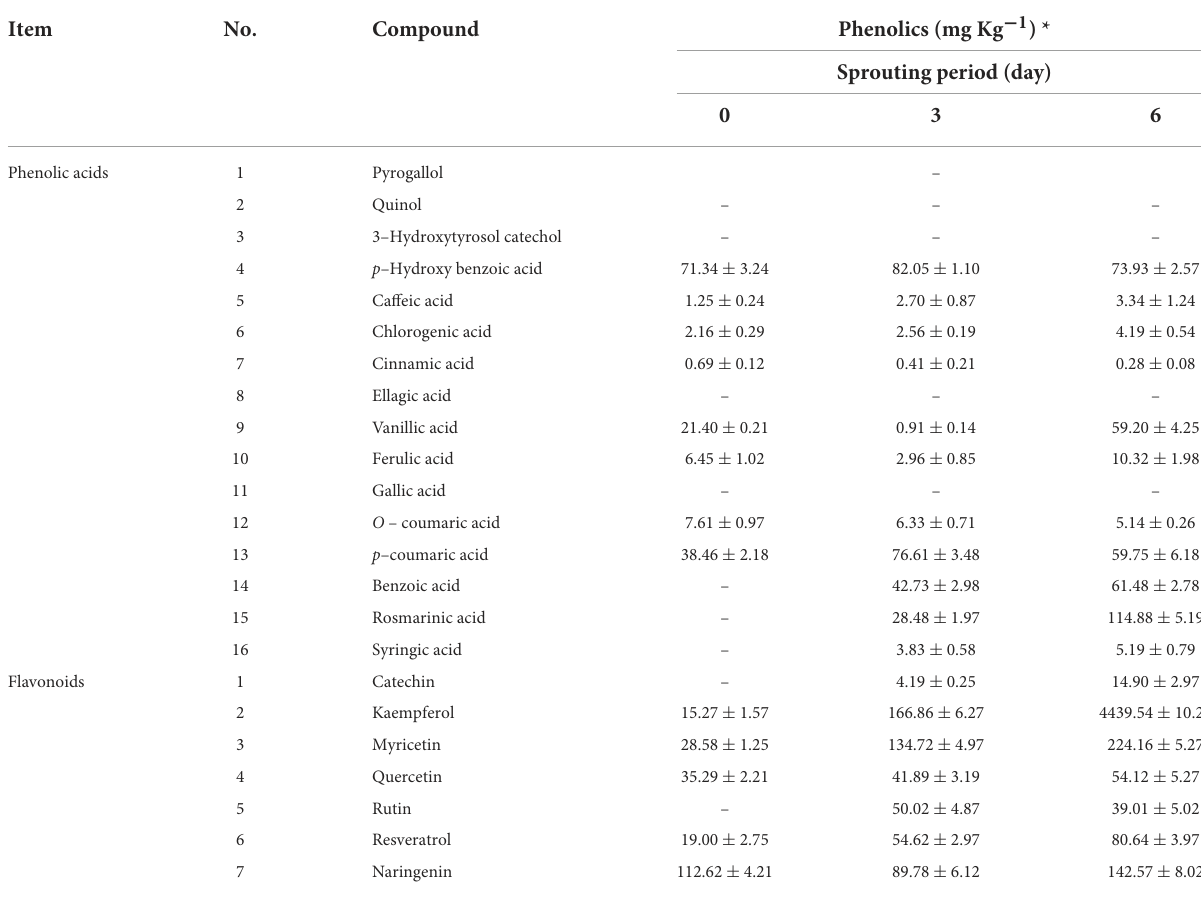
TABLE 2 Quantitative analysis of phenolic compounds in L. culinaris during sprouting at 20 ± 1 ◦ C and 90–93% RH (mean ± SE), n = 3.